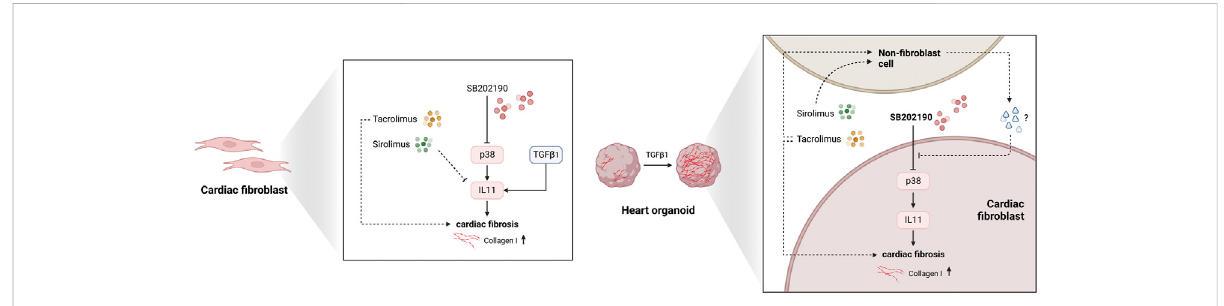
FIGURE 5 The biological model for the effects of Sirolimus and Tacrolimus effects in fi broblast and non- fi broblast populations. Illustration representing the 2D and 3D models explaining the non-cell-autonomous molecular phenotypic divergences with Sirolimus and Tacrolimus reverting the anti fi brotic-response of p38-MAPK inhibition derived from